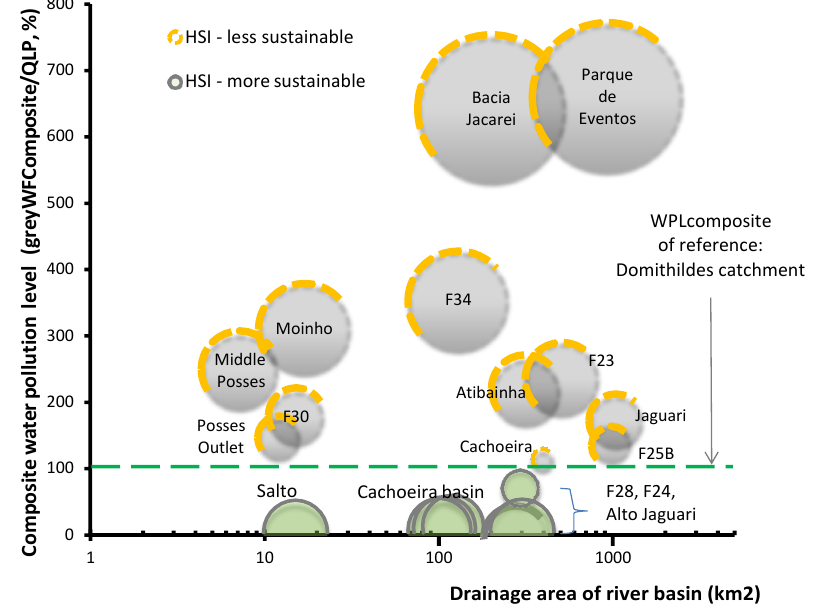
Figure 16. Hydrologic service index (circle ratio) related to drainage area of river basin (horizontal axis) and composite of water pollu- tion index (vertical axis) for the S2 + EbA scenario: equal weights of nitrate, total phosphorus and dissolved sediments are expressed in WPL composite,ref